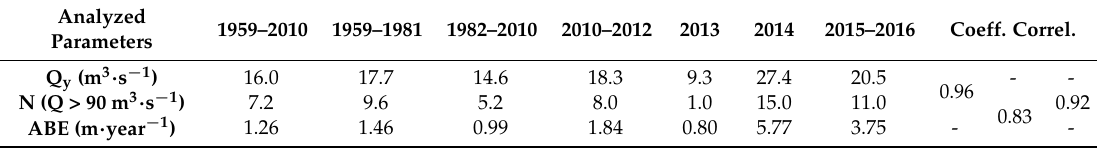
Table 6. The relationship between the mean annual discharge (Q y ), the number of days per year with the discharge exceeding a selected threshold of 90 m 3 · s − 1 (N), and average annual river bank erosion rate (ABE). the discharge exceeding a selected threshold of 90 m 3 ·s − 1 (N), and average annual river bank erosion rate (ABE).